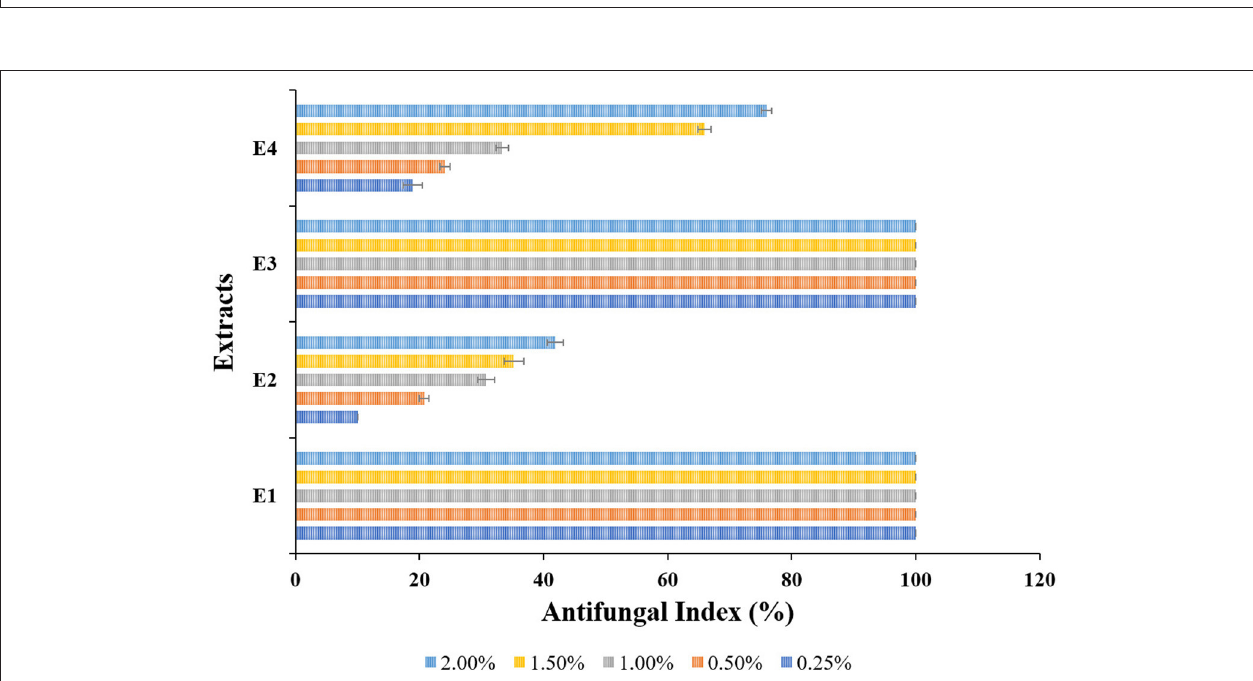
FIGURE 3 | Antifungal index (%) of different extracts from Lantana camara (E1, E2) and Ageratum conyzoides (E3, E4) against Laetiporus sulphureus at 0.25, 0.50, 1.00, 1.50, and 2.00% concentrations.